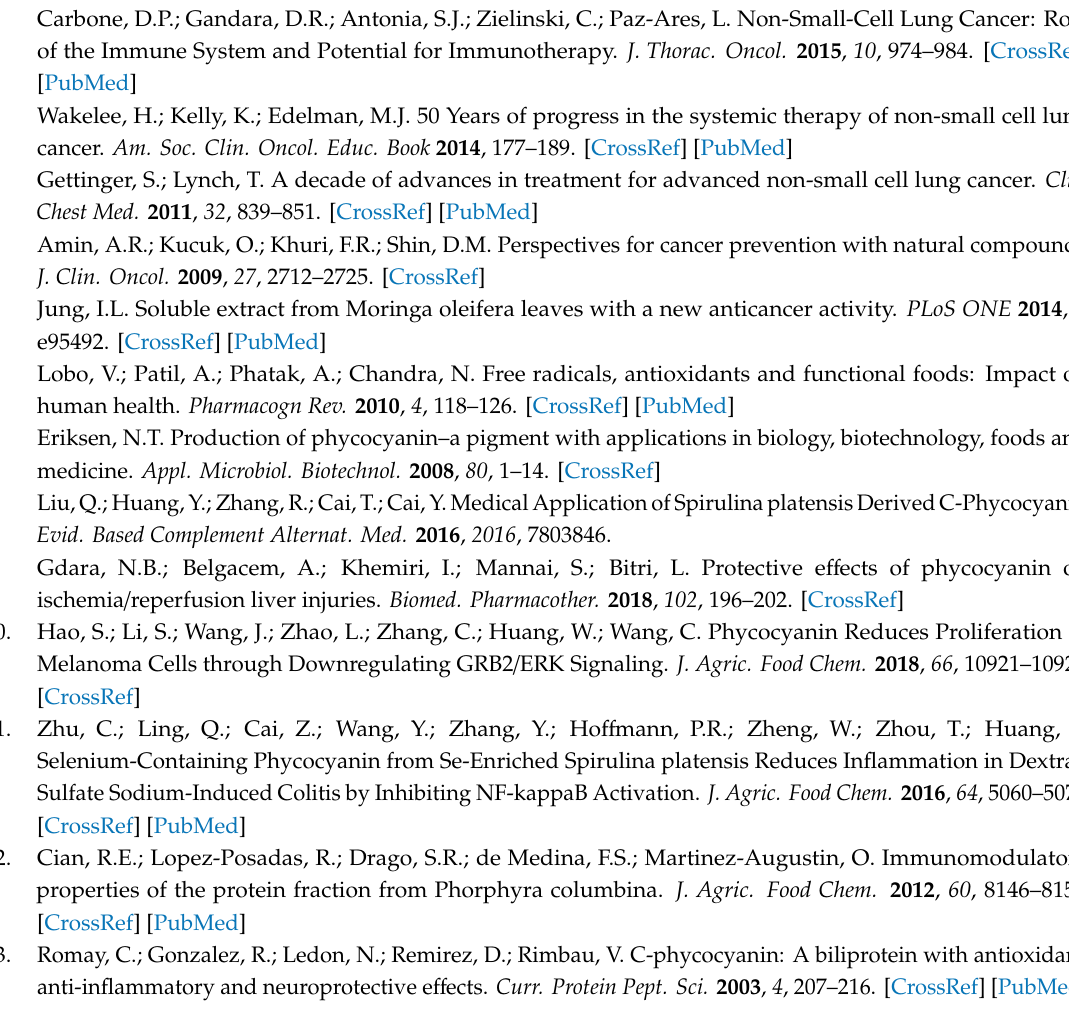
Figure S1: Validation of expressions of NF- κ B pathway-related genes in LTEP-a2 cells after phycocyanin treatment, Figure S2: Western blot detection of total amounts of NF- κ B signaling proteins and analysis of phosphor / total protein expression